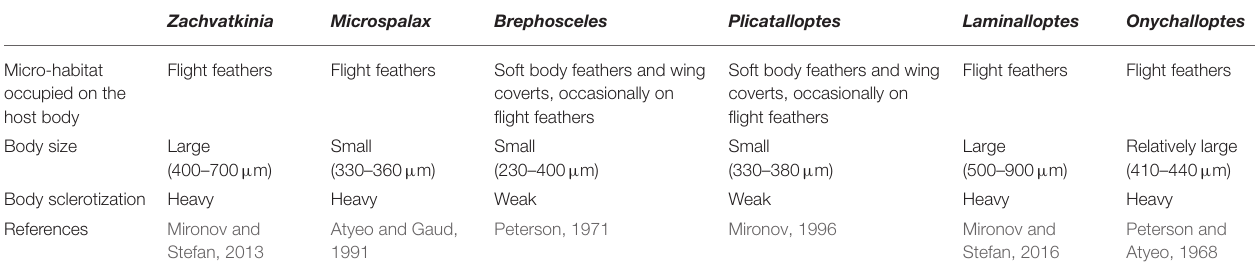
TABLE 1 | Key differences in life-history traits of the feather mite genera.